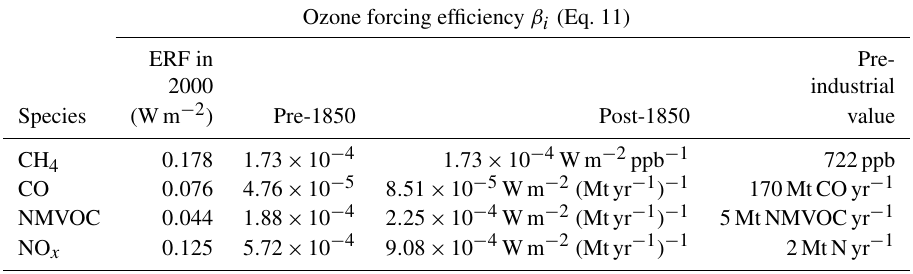
Table 4. Contribution to tropospheric ozone ERF from each precursor. Pre-industrial emissions from Skeie et al. (2011), pre-industrial CH 4 from Meinshausen et al. (2011b), 1850 and 2000 emissions from Lamarque et al. (2010), and 2000 minus 1850 ERF from Stevenson et al.